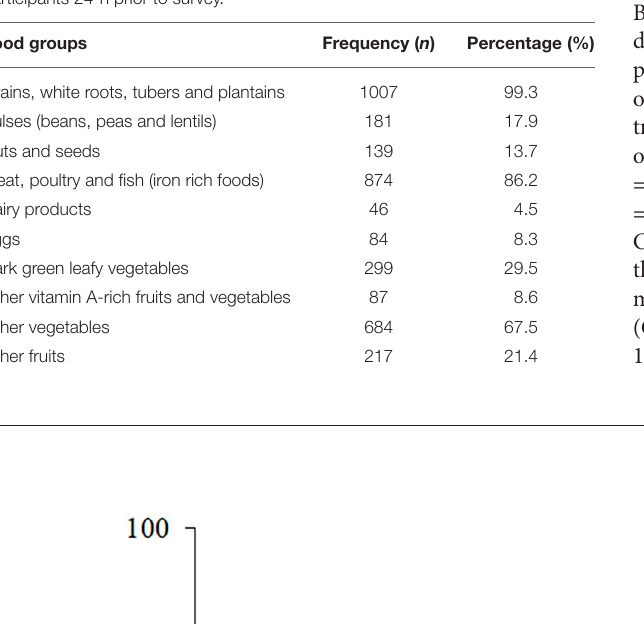
Figure 2 . Intake of dairy products ( P < 0.001), meat, fish